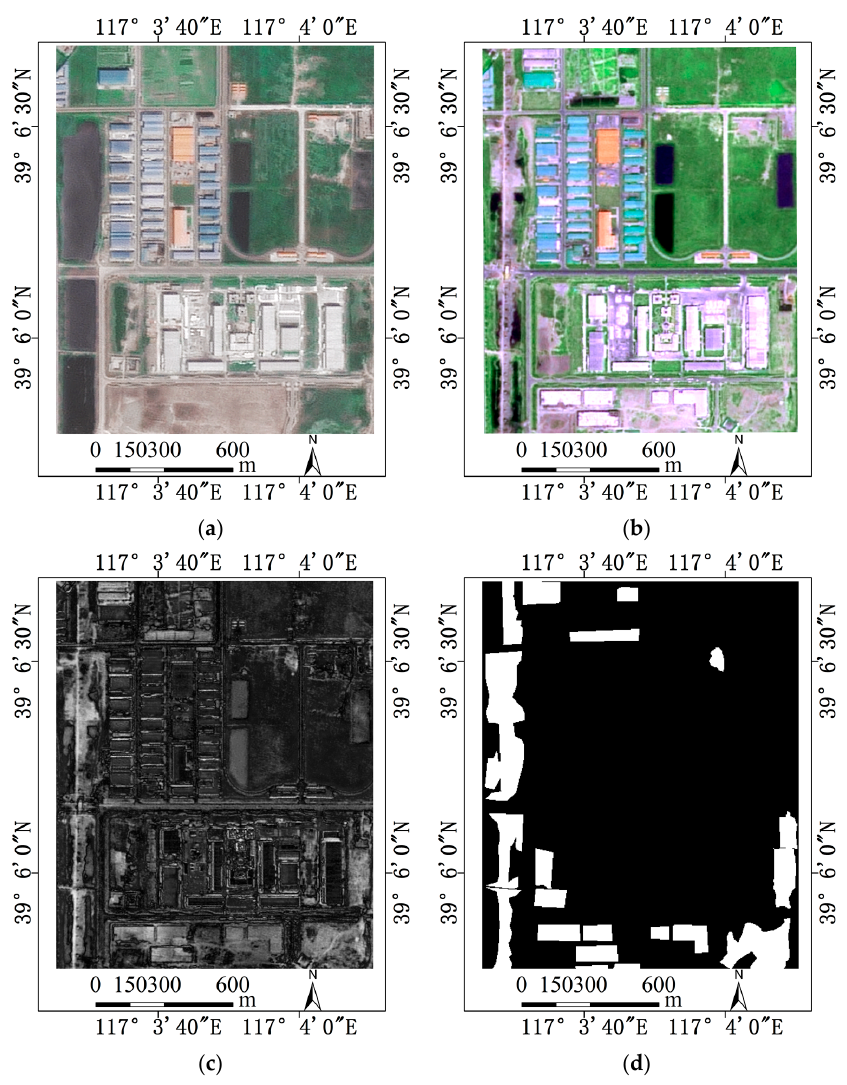
Figure 8. Fused images of data set 2 acquired by SPOT 5 in ( a ) August 2008 and ( b ) February 2009; ( c , d ) are the difference image and reference image, respectively.